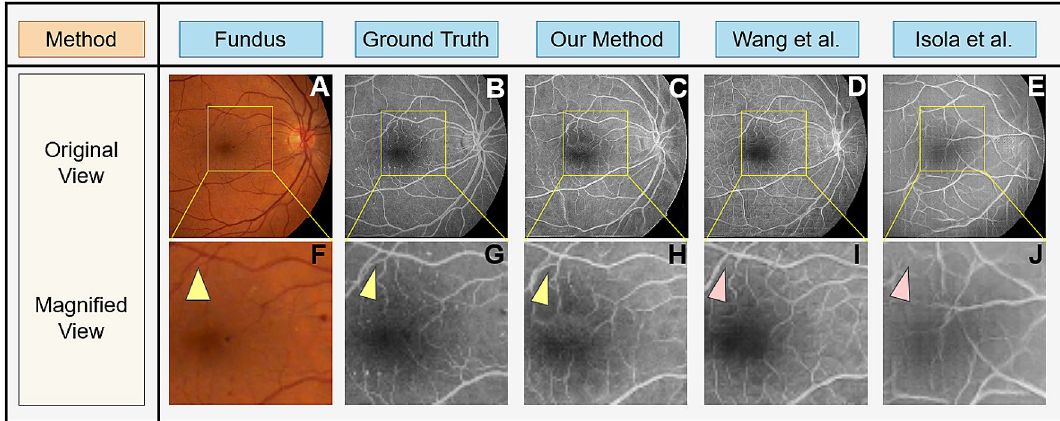
Figure 4. Paired fundus photographs ( A ) and ground truth FA images ( B ). FA images generated by our proposed method ( C) and those generated by traditional GANs proposed by Wang et al. ( D ) 50 and Isola et al. ( E ) 27 . Subfigures ( F–J ) show magnification of the yellow boxed areas from ( A–E ). Microvascular structures are not quite visible in the fundus photographs ( A,F ), but are visible in the original FA images ( B,G ) pointed to by the yellow triangles. Our deep learning GAN is capable of producing these microvascular structures pointed to by the yellow triangle, as well as macro vasular structures ( C,H ). The GAN proposed by Wang et al. 50 misses these microvascular structures ( D,I ) while GAN proposed by Isola et al. 27 is not able to produce any reliable vascular structure ( E,J )—see red